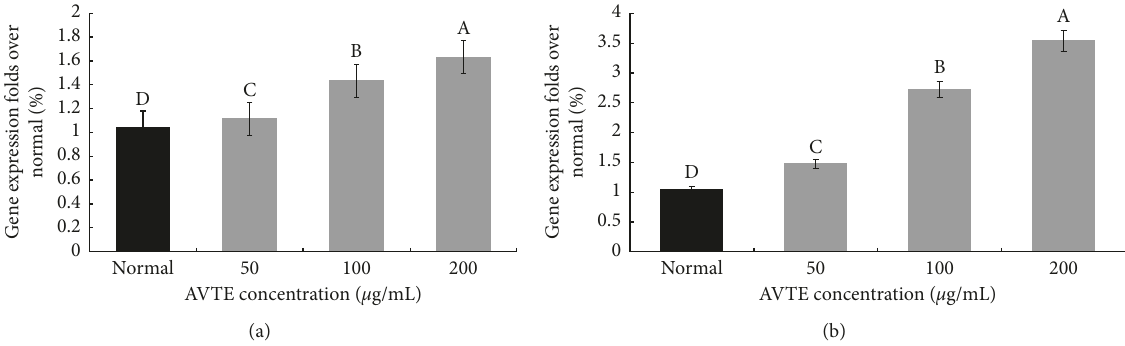
Figure 9: Effects of AVTE on gene expression of the growth-inhibiting gene p21 (a) and the growth-inhibiting and apoptotic gene p53 (b) in human hepatoma HepG2 cells. Fold ratio of p21 (a) and p53 (b) mRNA expression over the normal. The calculation formula is as follows: gene expression/GAPDH × normal numerical value (normal fold ratio: 1). A–D Mean values with different letters in the same bar graph are significantly different ( P < 0 . 05) according to Duncan’s multiple range